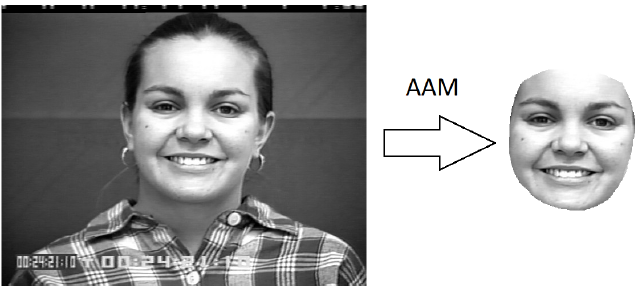
Figure 15. AAM shape estimation in a face from the CK+ database.